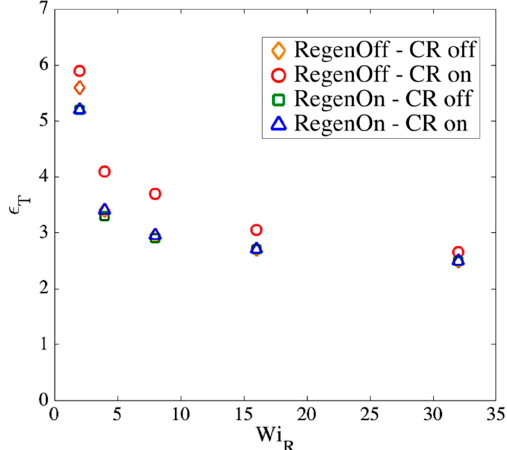
Figure 17. Transition strain ( (cid:101) T ) as a function of Rouse Weissenberg number ( Wi R ) for a chain with Figure 17. Transition strain ( 𝜖 (cid:3021) ) as a function of Rouse Weissenberg number ( 𝑊𝑖 (cid:3019) ) for a chain with Figure 17. Transition strain ( 𝜖 (cid:3021) ) as a function of Rouse Weissenberg number ( 𝑊𝑖 (cid:3019) ) for a chain with 𝑁 (cid:3046) = 32 springs under different renewal/CR algorithms. A constant value of 𝐹 (cid:3046)(cid:3046) (cid:3040)(cid:3028)(cid:3051) is used for all N s = 32 springs under different renewal/CR algorithms. A constant value of F max ss is used for all 𝑁 (cid:3046) = 32 springs under different renewal/CR algorithms. A constant value of 𝐹 (cid:3046)(cid:3046) (cid:3040)(cid:3028)(cid:3051) is used for all four conditions. four conditions. four conditions.